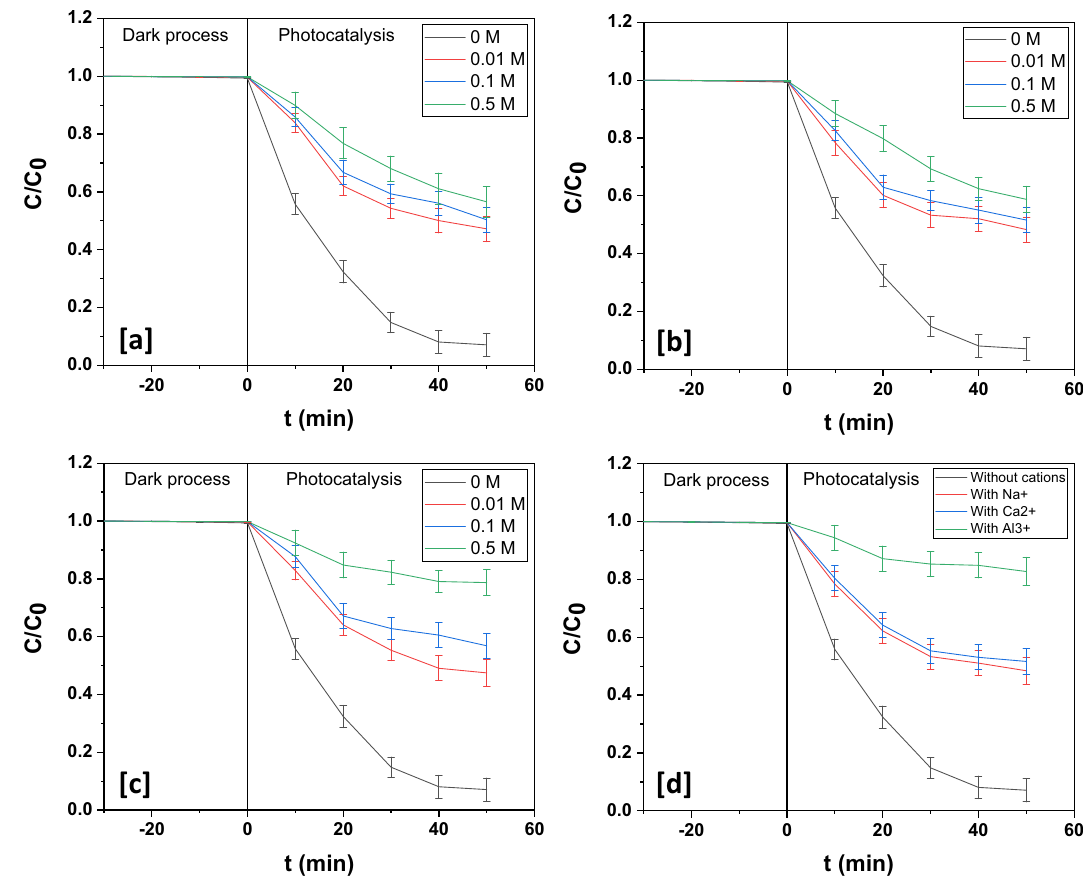
Figure 14. Photodegradation dynamic curves of esomeprazole in presence of different concentrations of ( a ) chloride, ( b ) sulfate and ( c ) bicarbonate over In 2 O 3 /MoS 2 /Fe 3 O 4 . ( d ) Photodegradation dynamic curves of esomeprazole in presence of different cations over In 2 O 3 /MoS 2 /Fe 3 O 4